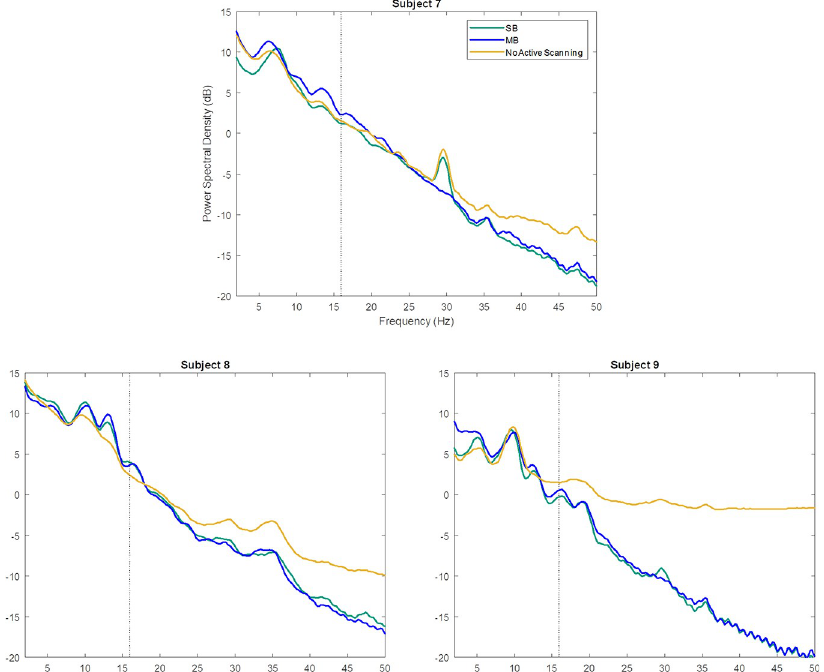
Fig 6. Comparison of EEG log-power spectrogram across different concurrent fMRI conditions during eyes- closed resting state for three human subjects. Power spectral density averaged across all channels directly comparing the MB sequence, SB sequence, and fMRI-free conditions for Subjects 7–9. The dotted black line denotes the RF excitation repetition frequency for the MB and SB sequences (15.9 Hz and 16 Hz respectively, indistinguishable on this